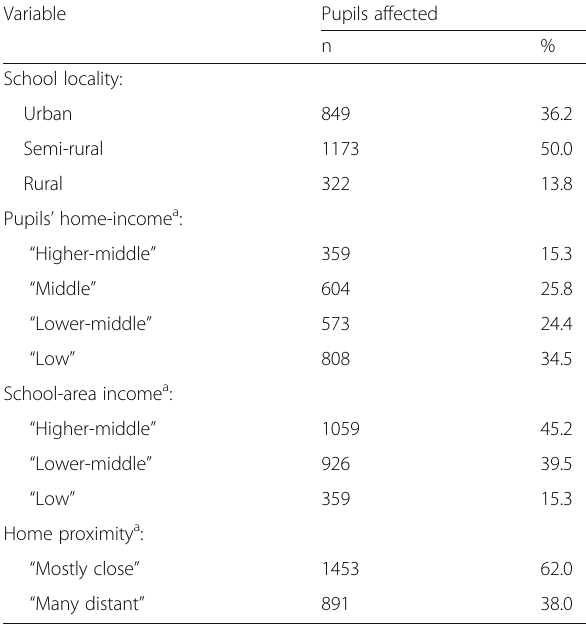
Table 1 School variables (from teachers ’ questionnaires), and numbers of participant pupils affected ( N = 2344)